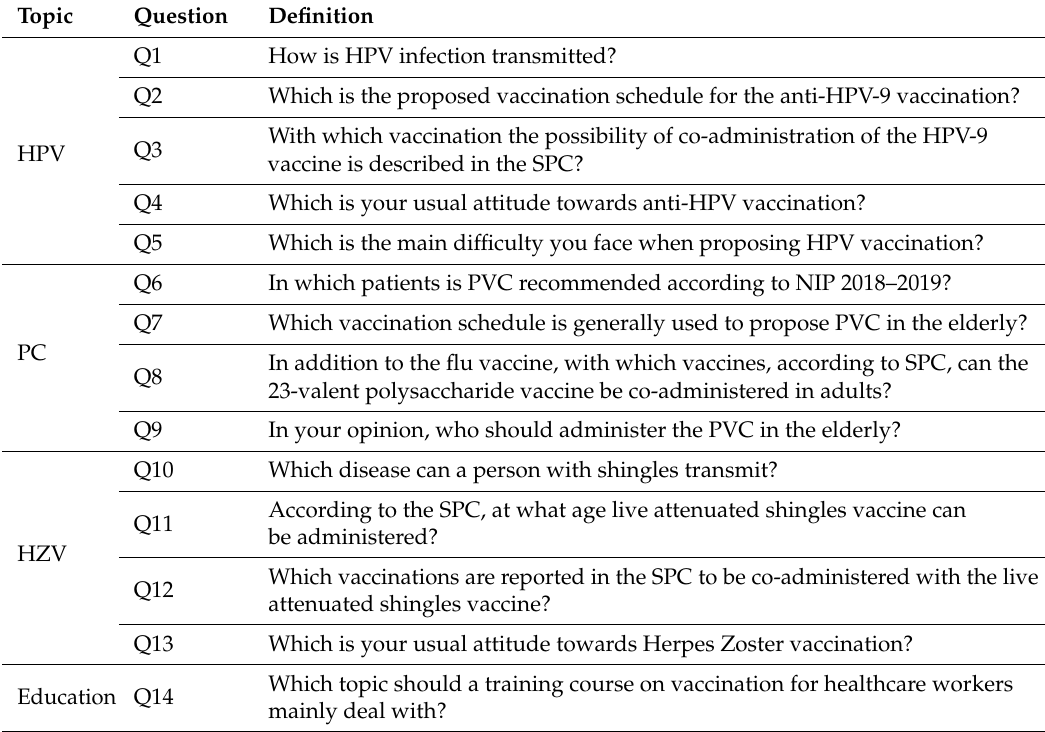
Table 1. Topics and definition of the